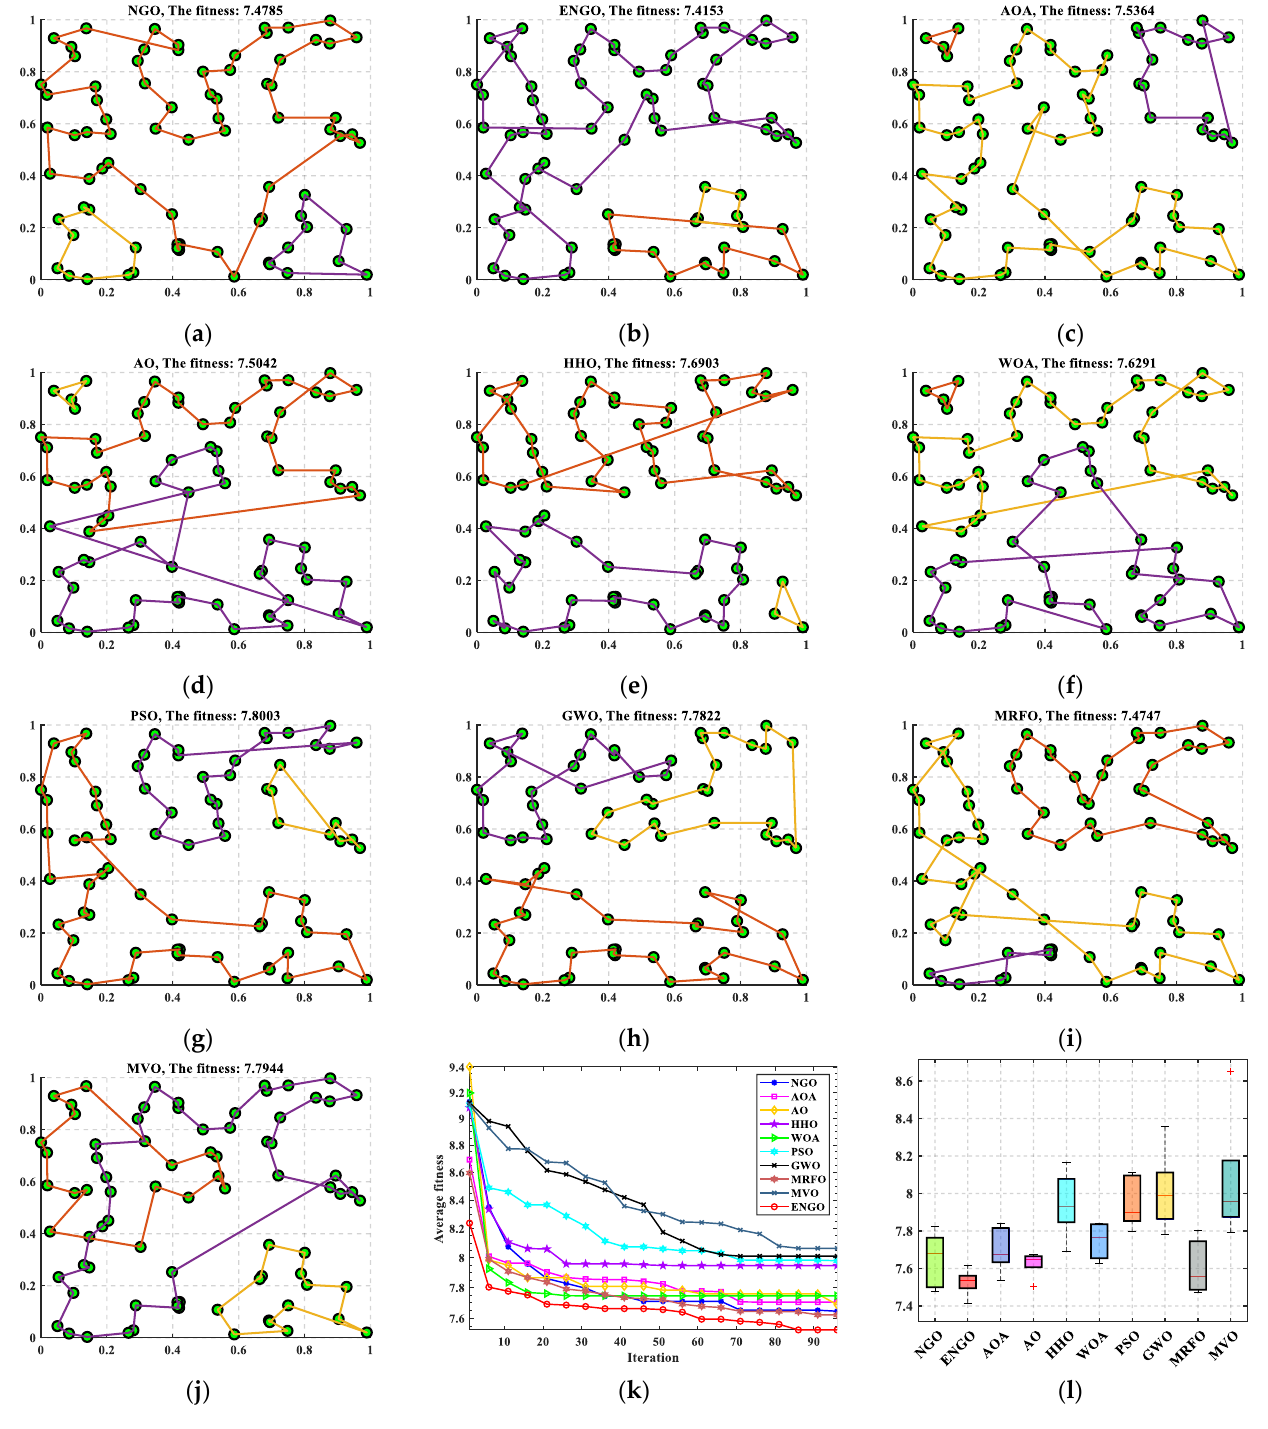
Figure 14. The best results, convergence and box plot of all algorithms for the TSP with 80 cities and three traveling salesmen. ( a ) NGO; ( b ) ENGO; ( c ) AOA; ( d ) AO; ( e ) HHO; ( f ) WOA; ( g ) PSO; ( h ) GWO; ( i ) MRFO; ( j ) MVO; ( k ) The convergence curve; ( l ) The box plot.